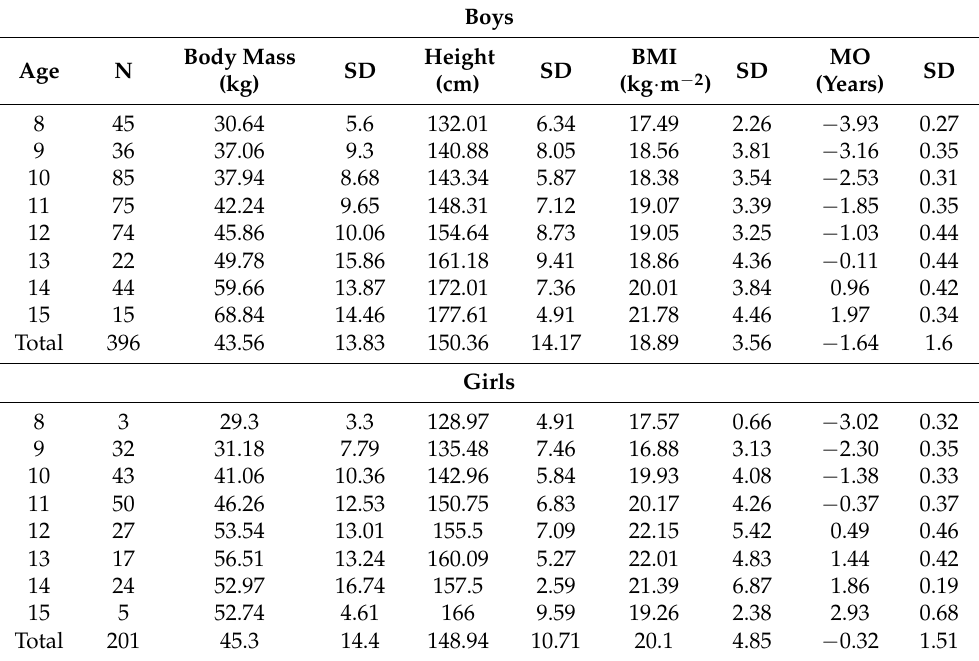
Table 1. The number of children in the sample, plus the mean ( ± SD) body mass, height and maturation offset by sex and age